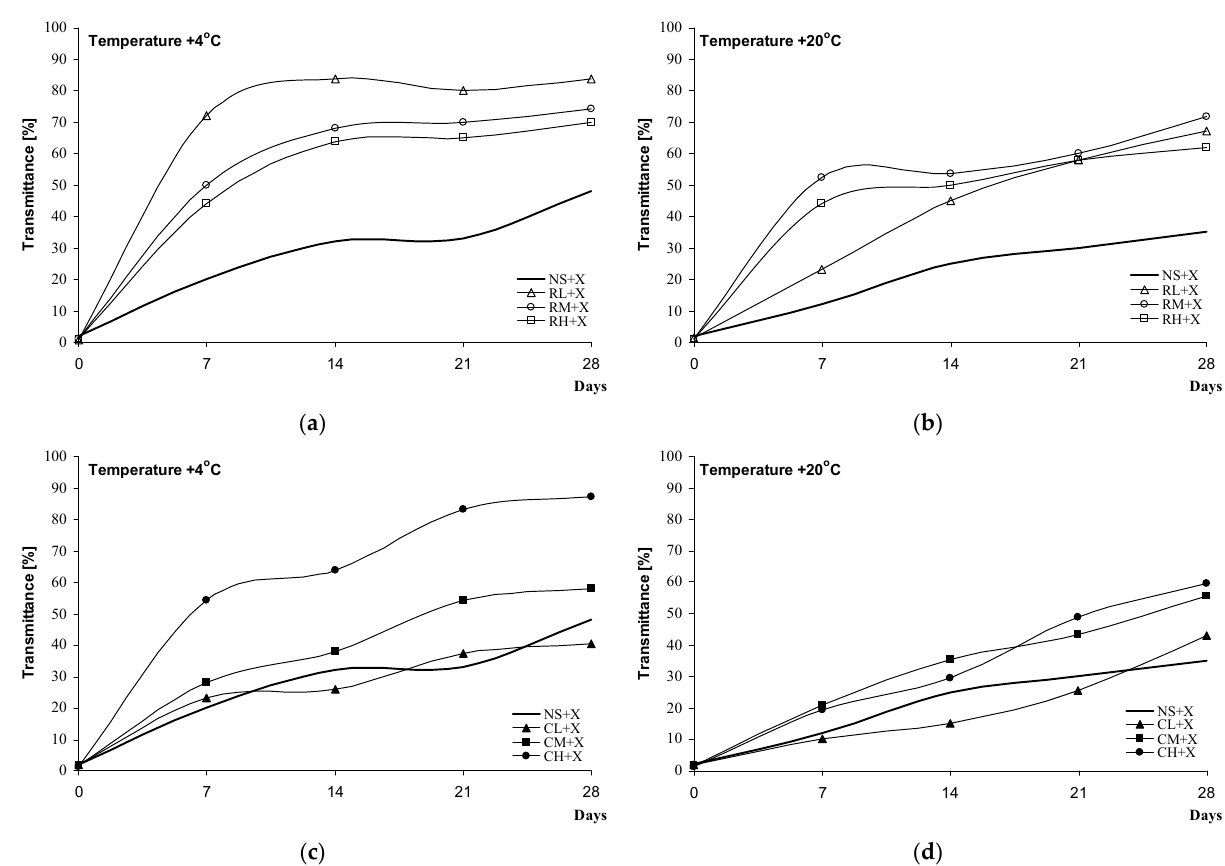
Figure 5. Retrogradation of black jelly-like desserts prepared on the basis of chemically ( a , b ) or physically ( c , d ) modified starches sweetened with xylitol.